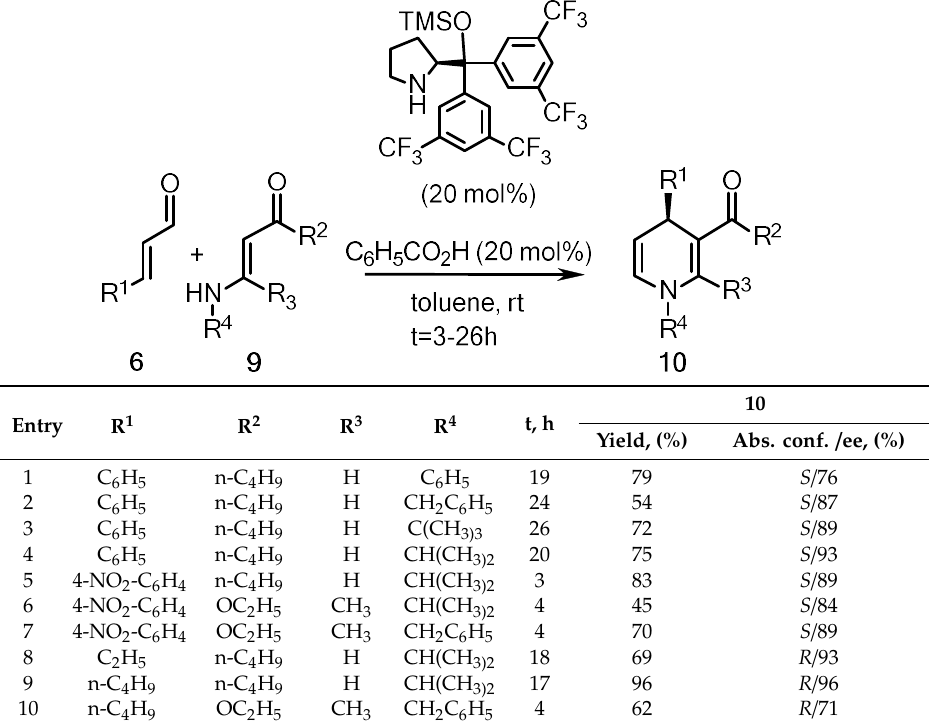
Table 5. Organocatalytic reaction β-enaminones and β-enamino esters 9 with α,β-unsaturated aldehydes 6 [59].